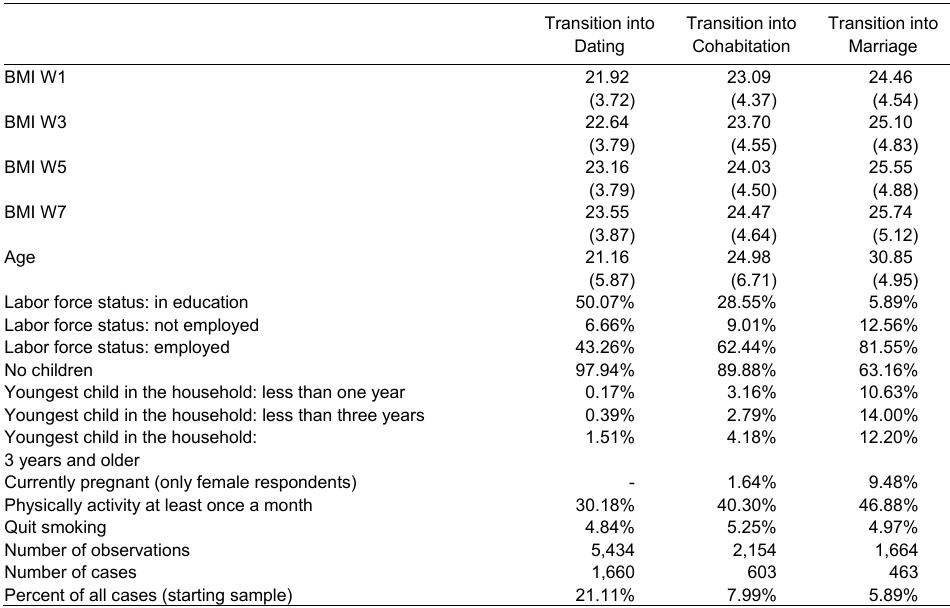
Table 2 : Mean and standard deviations (in parentheses) for individuals belonging to a treatment group